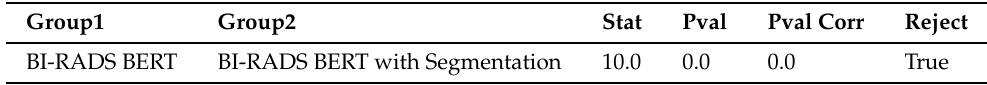
Table A24. McNemar test results for field extraction of menopausal status.